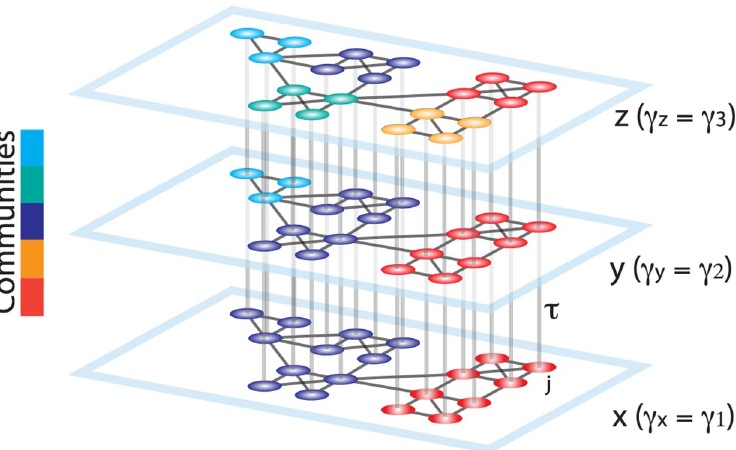
Fig 1. Schematic representing the construction of a multilayer network for use in multi-scale modularity maximization. Duplicates of a graph are connected in a multilayer fashion to construct a 3D graph. The smallest resolution parameter γ is assigned to the first layer ( x ), and it is linearly increased for the neighboring layers ( y , z ). The topological scale coupling parameter, τ , tunes the strength of the dependence of communities across layers. Since the community assignments are dependent on the adjacent layers, nodes that display high clustering over neighboring topological scales are identified as a single community spanning several scales. In this schematic, the large communities identified at initial layers progressively break into smaller sub-communities, revealing the hierarchical community organization of the graph.